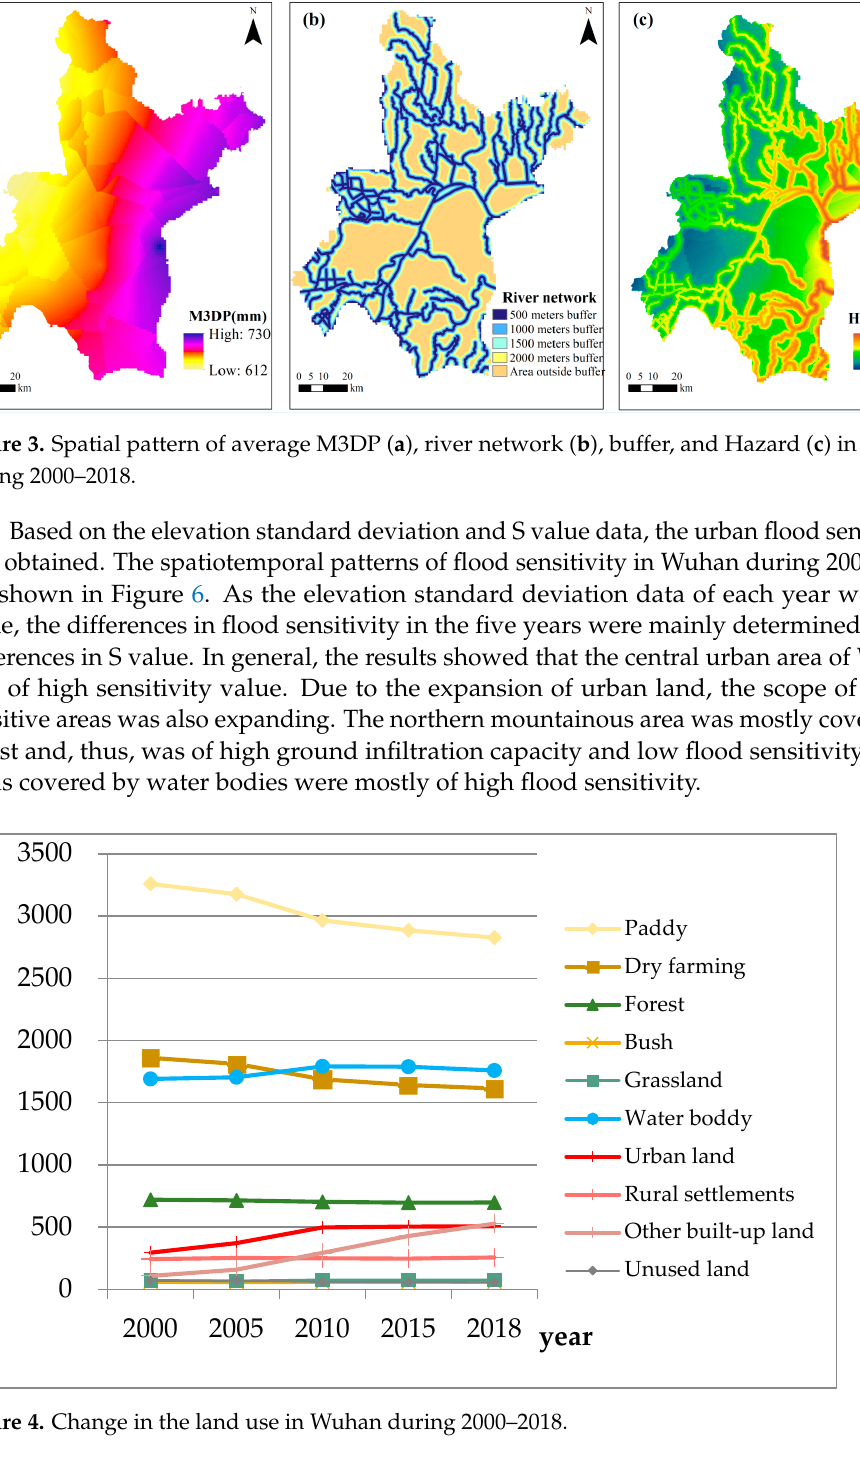
Figure 5. Spatiotemporal patterns of land use of 2018 ( a ) and standard derivation of elevation and maximum possible retention ( S ) in Wuhan (( b ) 2000, ( c ) 2005, ( d ) 2010, ( e ) 2015, ( f ) 2018). Based on the elevation standard deviation and S value data, the urban flood sensitiv ‐ ity was obtained. The spatiotemporal patterns of flood sensitivity in Wuhan during 2000– 2018 are shown in Figure 6. As the elevation standard deviation data of each year were the same, the differences in flood sensitivity in the five years were mainly determined by the differences in S value. In general, the results showed that the central urban area of Wuhan was of high sensitivity value. Due to the expansion of urban land, the scope of highly sensitive areas was also expanding. The northern mountainous area was mostly covered by forest and, thus, was of high ground infiltration capacity and low flood sensi ‐ tivity, while areas covered by water bodies were mostly of high flood sensitivity.